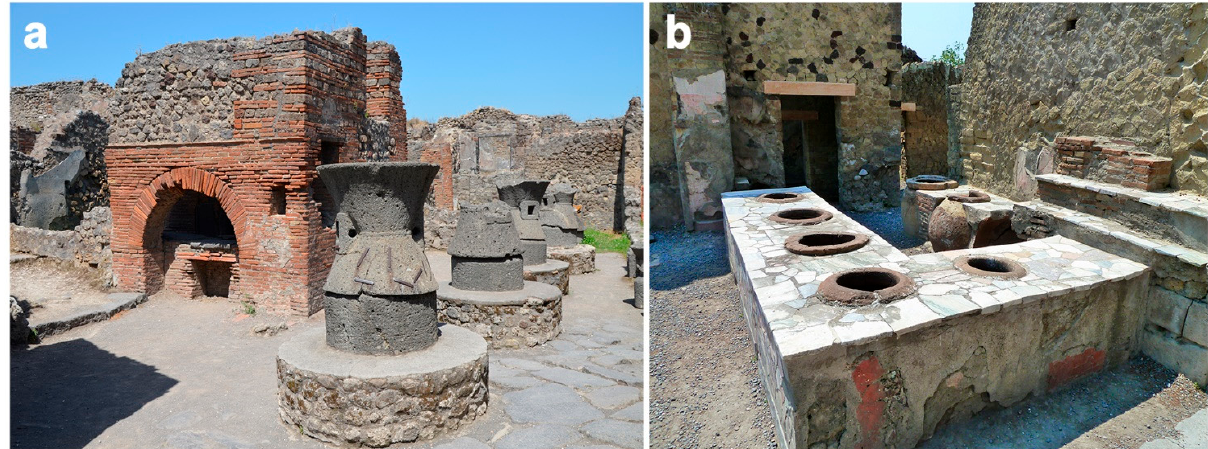
Figure 6. ( a ) The remains of the Pistrinum of Popidius Priscus ( Pompeii ) is a fine example of a bakery in which the whole cycle of breadmaking from milling to baking the bread was performed. The pistrinum contains four large millstones made from porous lava, traces of a stable, four storage rooms and a large oven, which was used for baking the bread [Author: Carole Raddato. Distributed under a CC BY-SA 2.0 license. Available online: https://cutt.ly/XRCZVTW. Accessed: 11 August